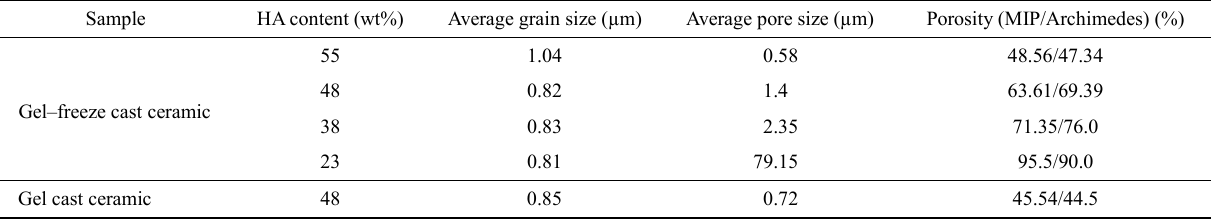
Table 3 Properties of the HA ceramics prepared by the gel − freeze casting and gel casting (all ceramics were sintered at 1100 ℃ for 6 h)